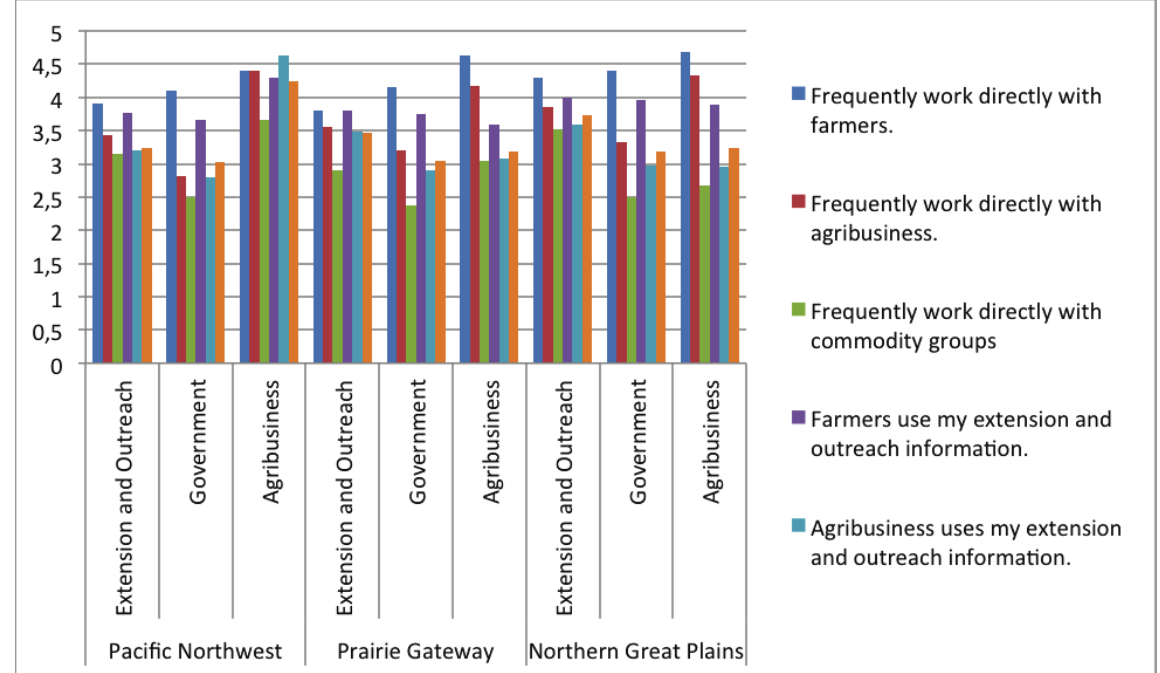
Figure 1: Target stakeholder group interactions and reception of information perception by extension and outreach agents in the western U.S. Statistics are the mean across responses on a Likert scale: 1= strongly disagree, 2= disagree, 3= neither agree nor disagree, 4= agree, and 5= strongly agree. (N =